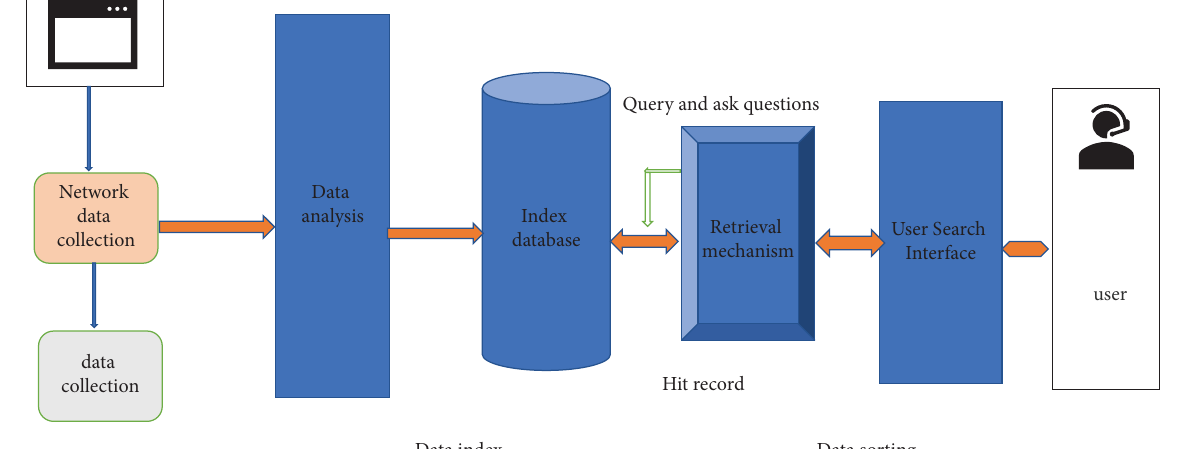
Figure 4: Texture features.